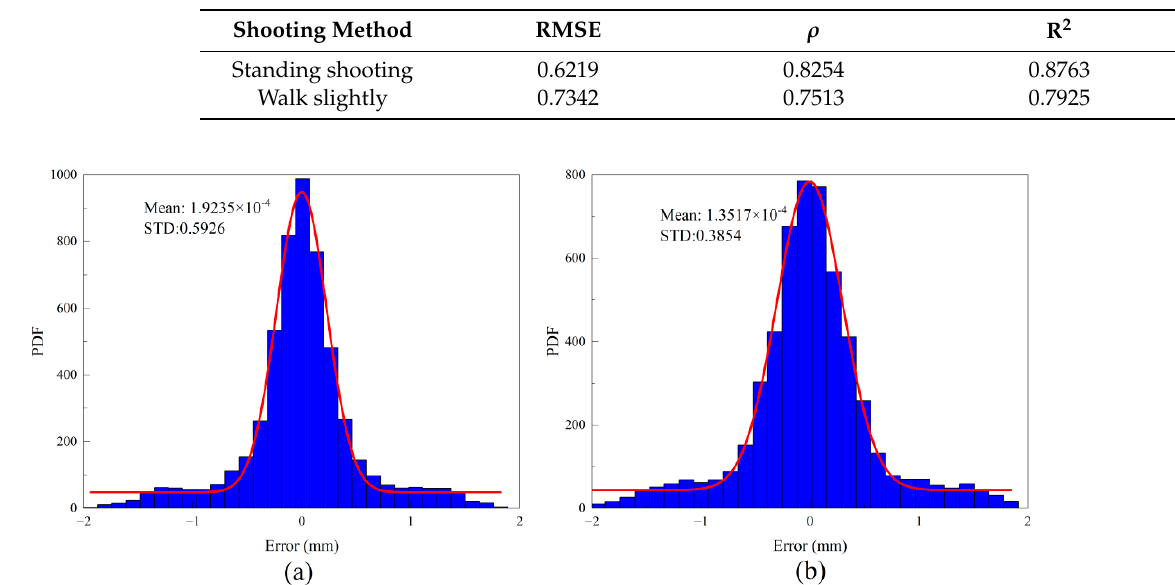
Figure 16. The error distribution of displacement monitoring under the common smartphone shoot- ing mode: ( a ) Standing shoot; ( b ) Shoot when walking